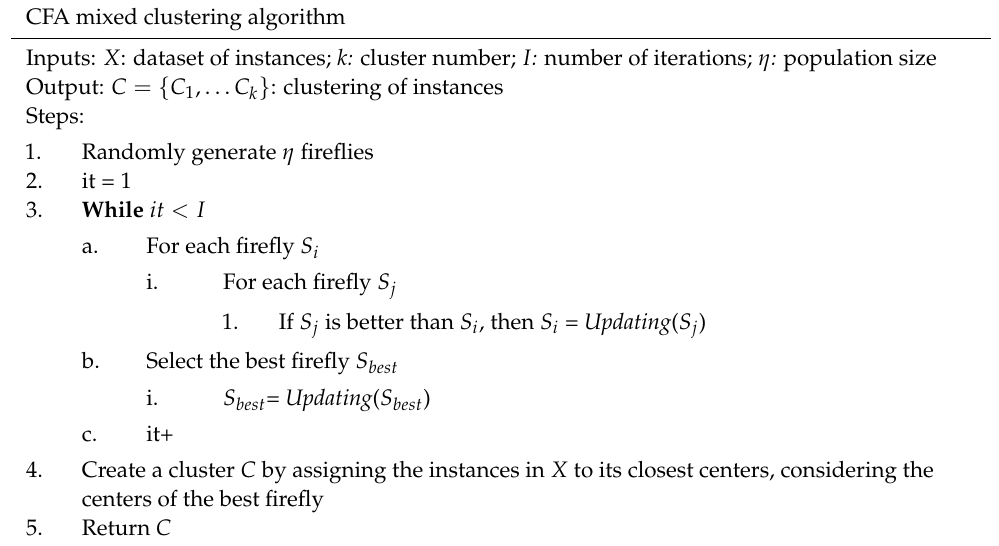
Algorithm 6. Pseudo code of the CFA algorithm to clustering mixed data. CFA mixed clustering